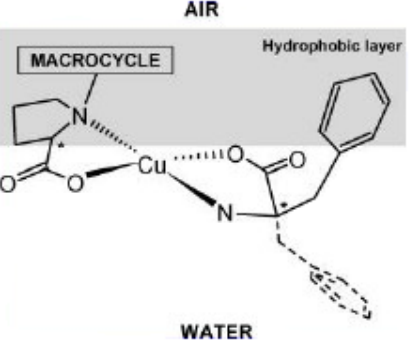
Figure 40. Schematic representation of the proposed interaction mechanism. The lateral chain of Phe is represented by a dashed line for the L -enantiomer (For clarity, only the prolyl moiety of L -RA-Pro is represented)